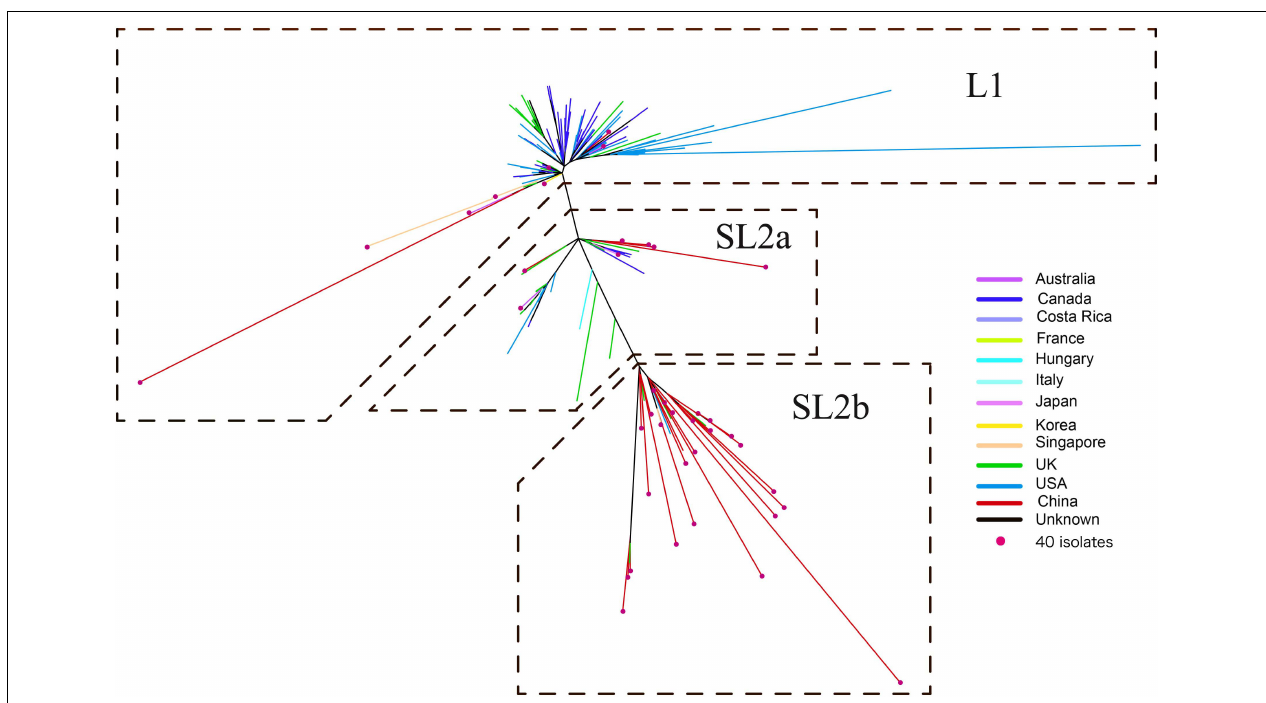
FIGURE 2 | Maximum likelihood phylogeny tree of C. difficile ST2. The different colors represented the different origins; the red dot marker was used for 40 C. difficile isolates by whole genome sequencing in this